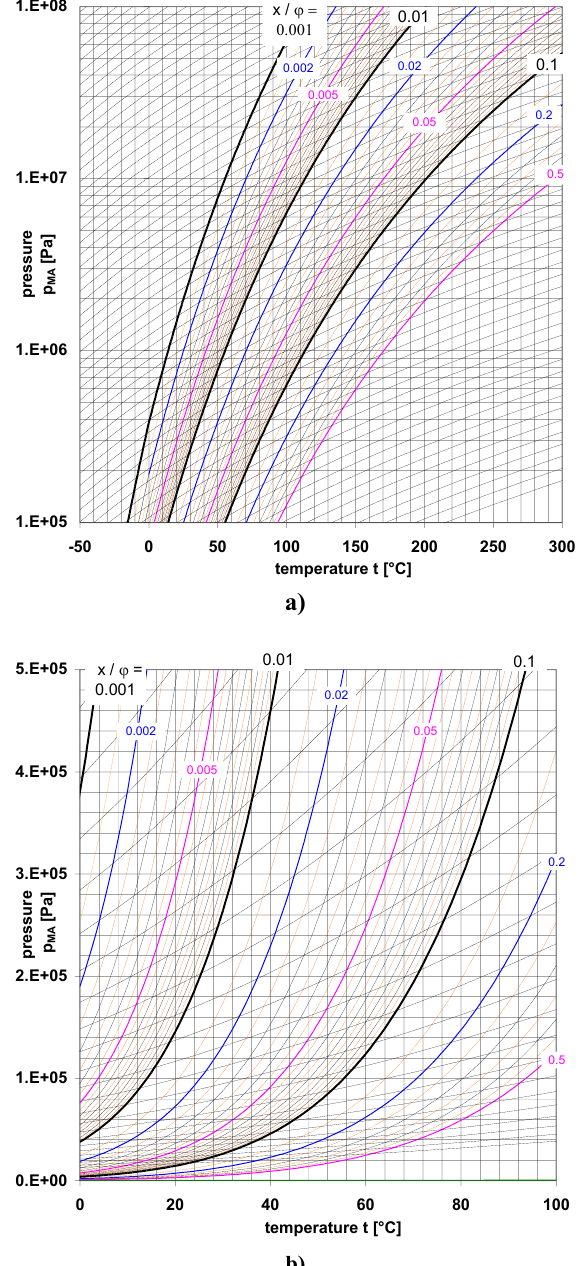
Fig. 4. Curves of constant ratio of specific moisture and relative moisture  / x in the equilibrium p - t moist air diagram.